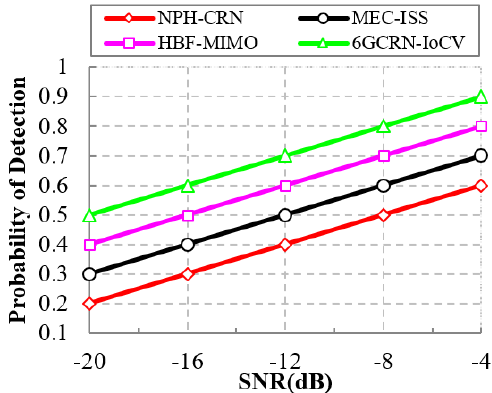
Figure 15. Probability of detection vs. SNR.